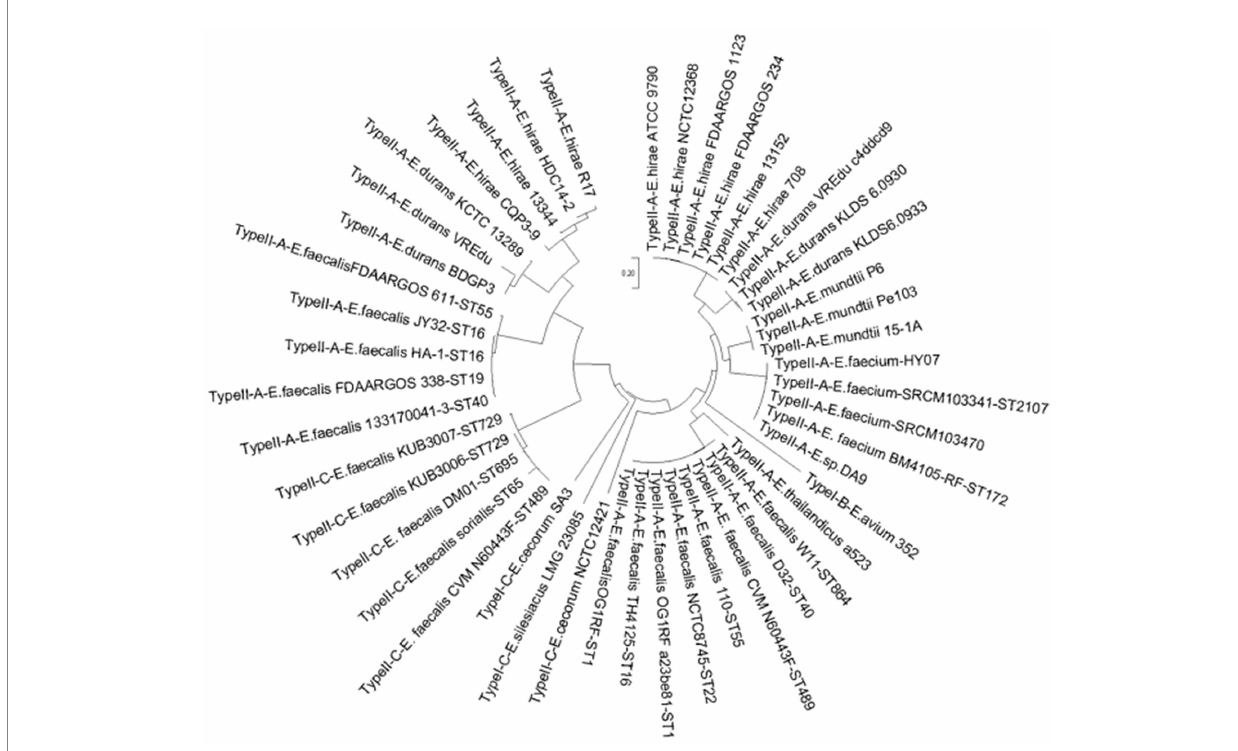
FIGURE 2 The phylogenetic tree based on Enterococcus 47 sets of cas1 genes. For the 47 sets of Cas 1 gene clusters contained in the genome of the 46 strains, the name format is CRISPR type + strain name + MLST type.